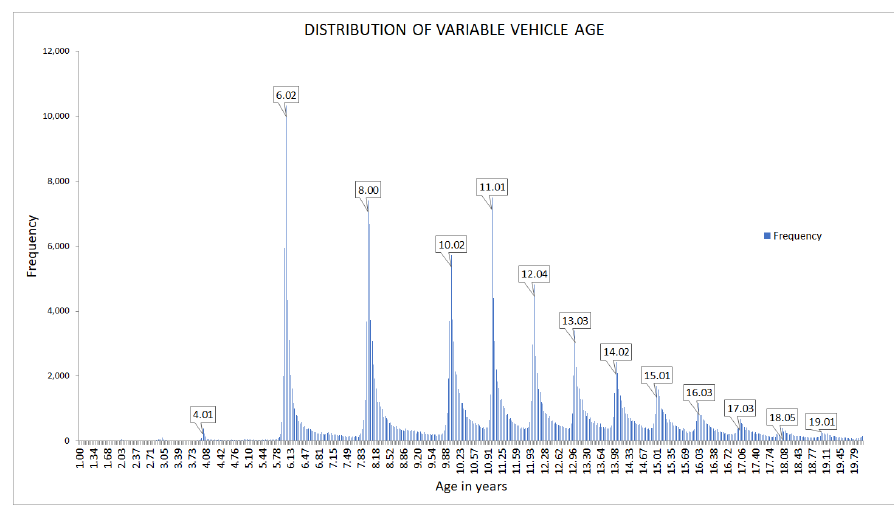
Figure 3. Distribution of variable vehicle age.